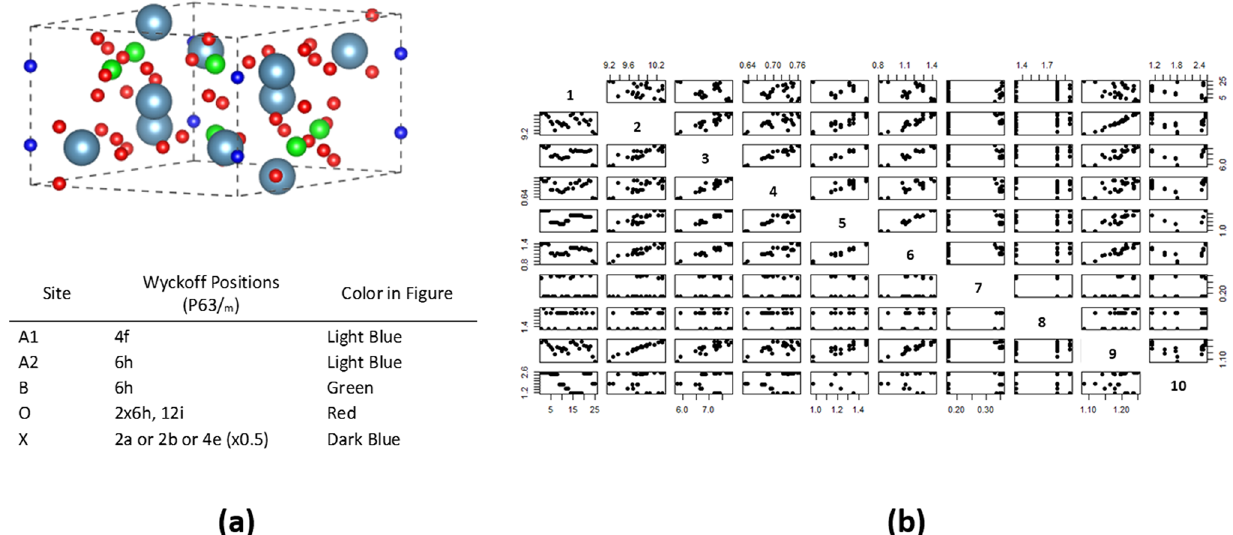
Figure 1. ( a ) The building of the apatite structure (A 5 (BO 4 ) 3 X) starts with the Wyckoff positions. ( b ) Standard structure map representation for defining correlations. For clarity, only the relationships of the first 10 descriptors (correlating with the labels in Table 1) are shown.